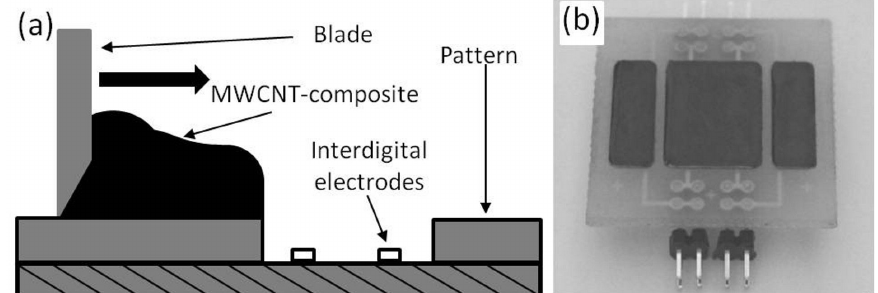
Figure 5. Fabrication of the piezo-sensitive layer: ( a ) principle of layer deposition by blade coating; ( b ) image of the fabricated sensing